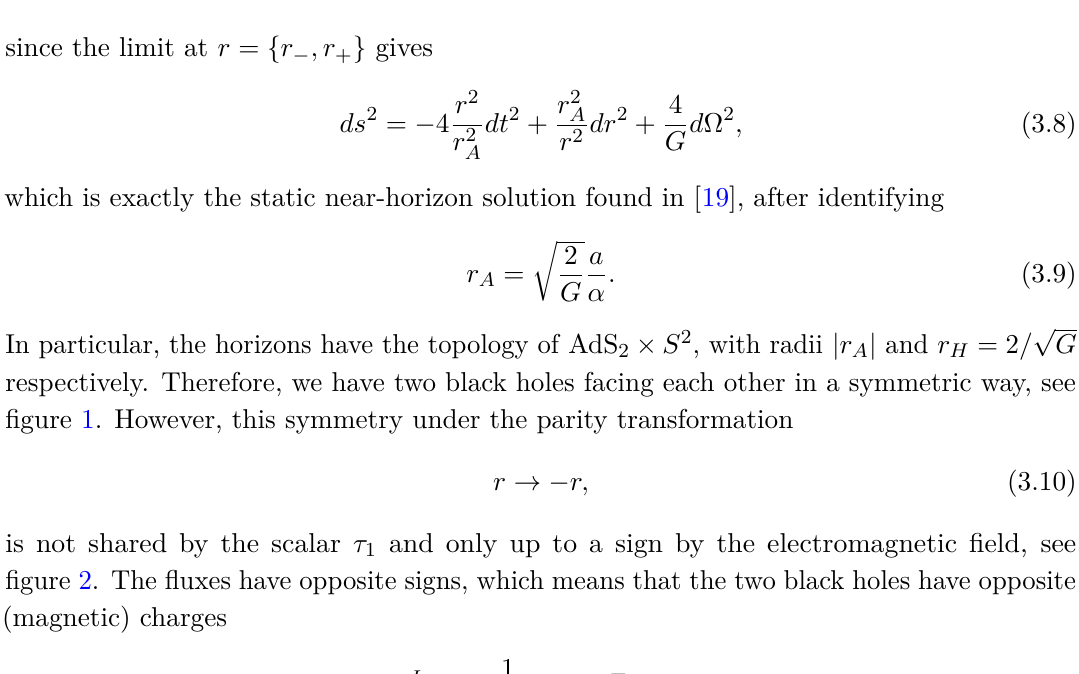
Figure 1 . Representation at t, φ constants of the geometry of the “Black hole dipole” with parameters G = 2 , c = 0 . 1 , r A = 1 . The circles are the lines of constant r and the longitudinal lines are the magnetic field lines. The horizons are at r ± = ± 10 and are represented in blue, while the √ singularities are the tips at r s ± = ± 10 2 . Here f ( r, θ ) = g θθ cos θ and g ( r, θ ) = g θθ sin θ